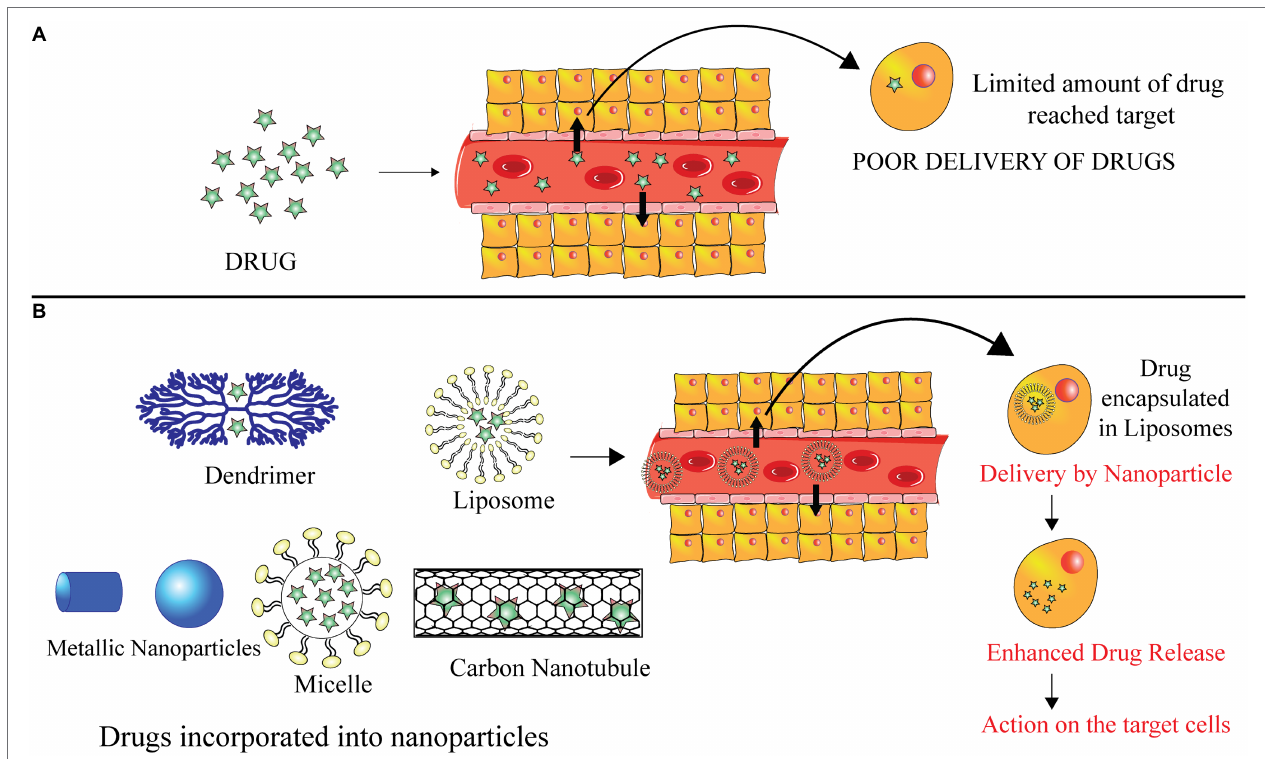
FIGURE 6 | Drug delivery mechanisms (A) . Conventional drug delivery targeting the affected region and displaying poor incorporation inside the tissue (B) . Drug delivery with the help of nanoparticles like dendrimers, carbon nanotubes, SNPs, micelles, and liposomes. These help in better and enhanced delivery of drug to the affected tissues and